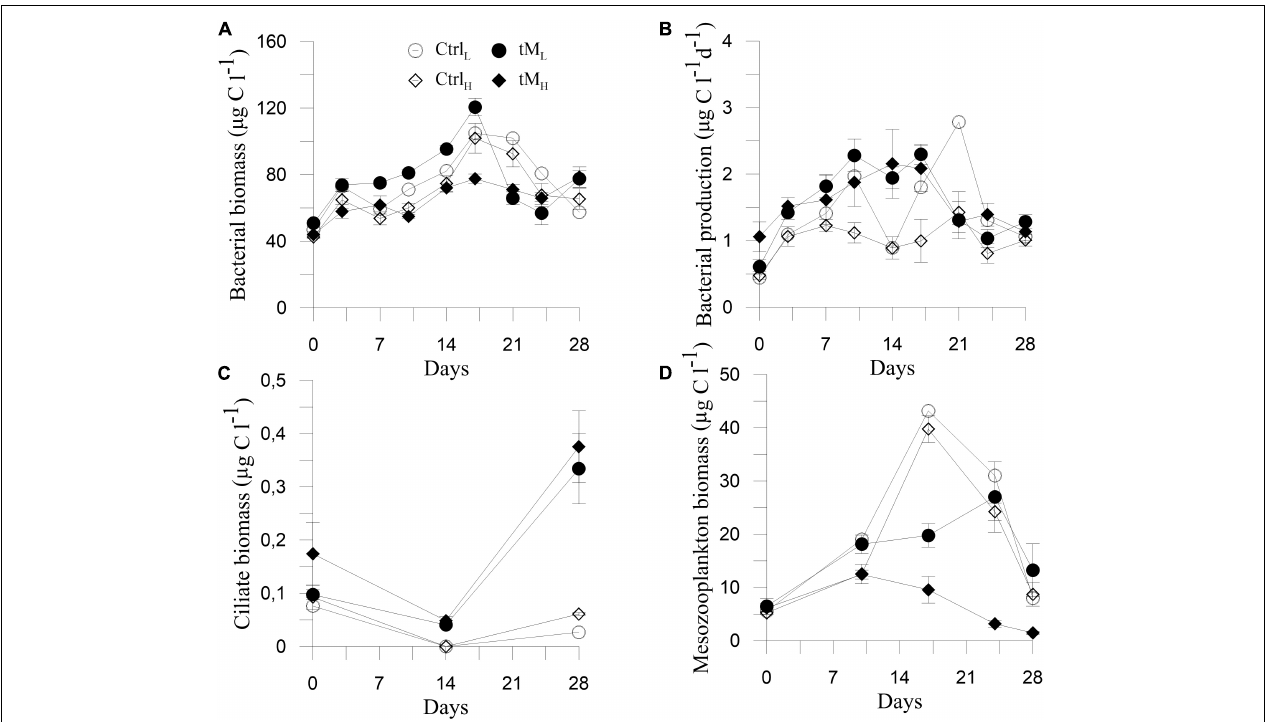
FIGURE 8 | Temporal variation of bacterial biomass (A) , bacterial production (B) , ciliate biomass (C), and mesozooplankton biomass (D) . Means ± standard error, n = 3.